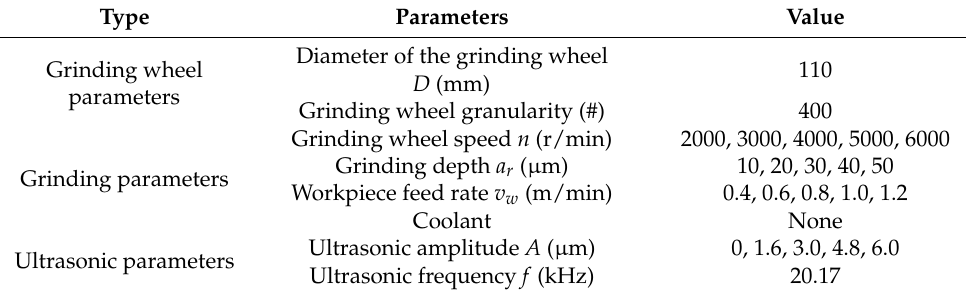
Table 1. Experimental